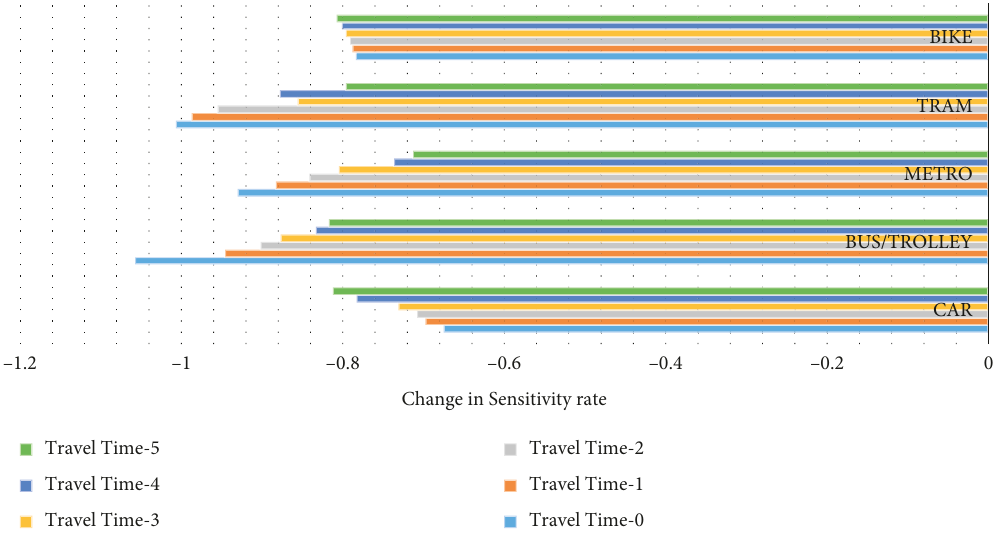
Figure 3: The coefficients values based on the changes in the physical parameter of the travel time.